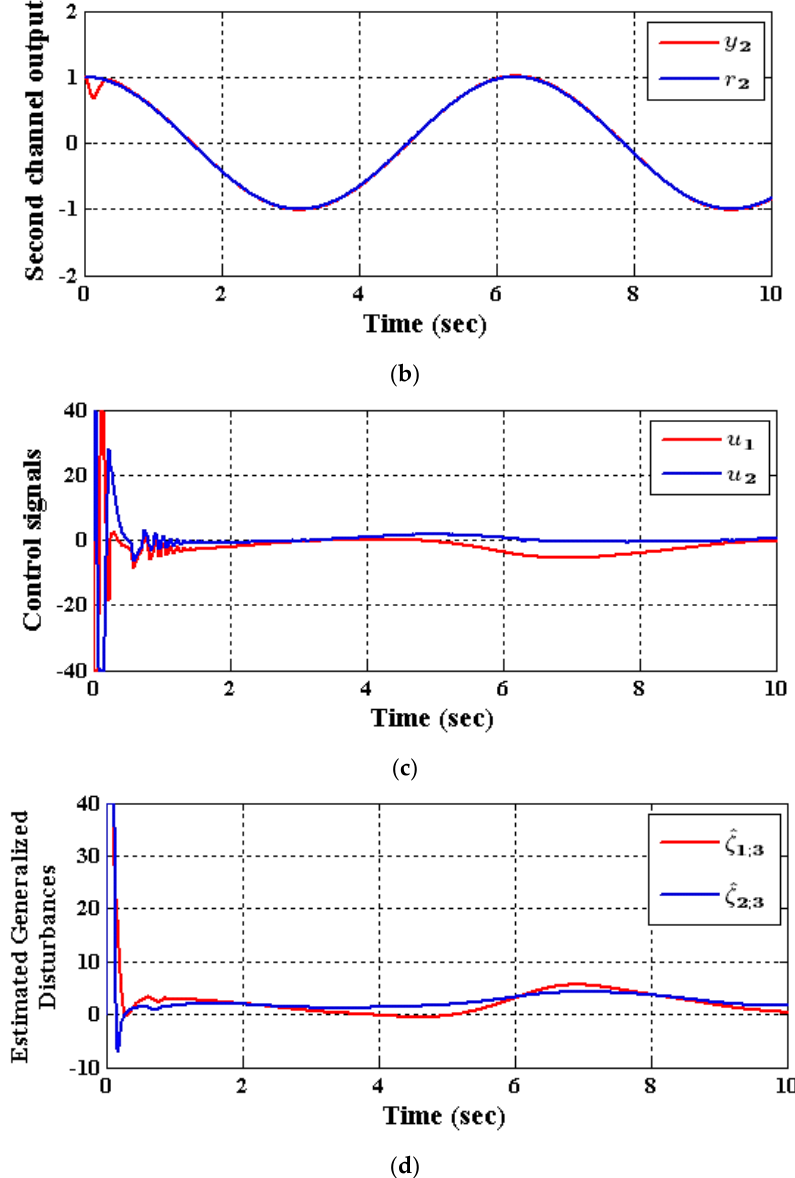
Figure 6. The output response of Equation (42) using CADRC configuration, ( a ) output y 1 , ( b ) output y 2 , ( c ) control signals u 1 and u 2 , and ( d ) estimated generalized disturbances ˆ ξ 1,3 and ˆ ξ 2,3 [23].